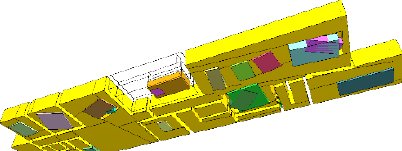
Figure 6: O-Spaces (colourful boxes) and extracted R-Spaces (yellow volumes). The image shows the spaces from below, because otherwise the obstacles (colourful boxes) are covered with free space from a top view. Walls are not included in this model.